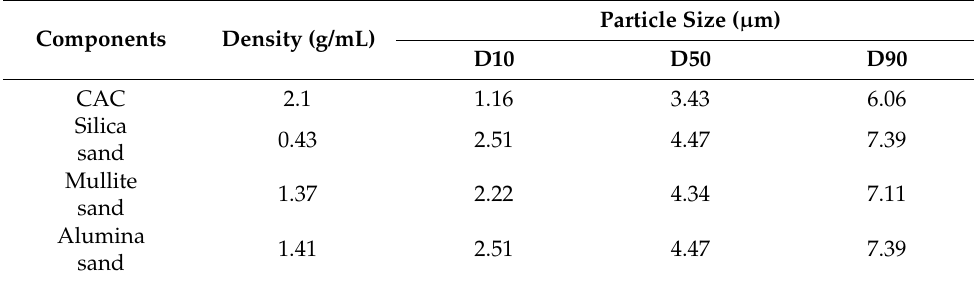
Table 1. Density and particle size distribution data of materials.